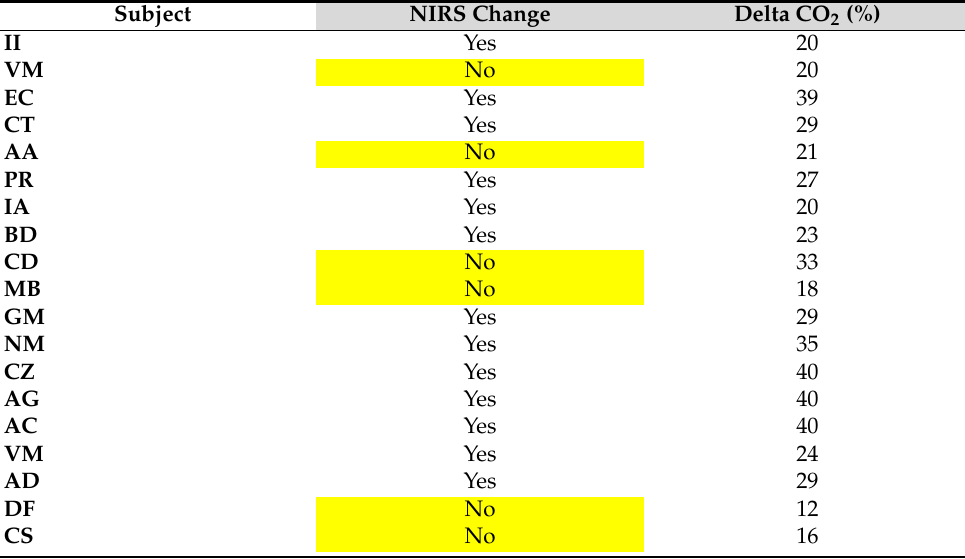
Table A2. NIRS Changes and the Amount of End-Tidal CO 2 Variation for Each